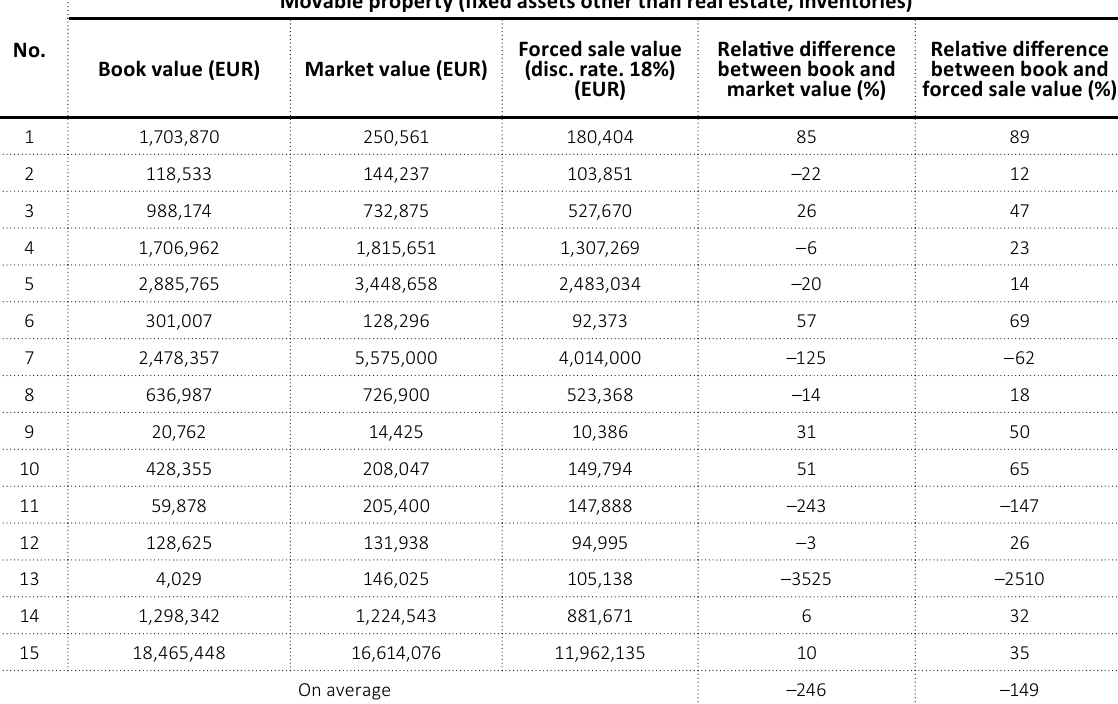
Table 4. Valuation of movable property comprising the bankruptcy estate in the examined enterprises